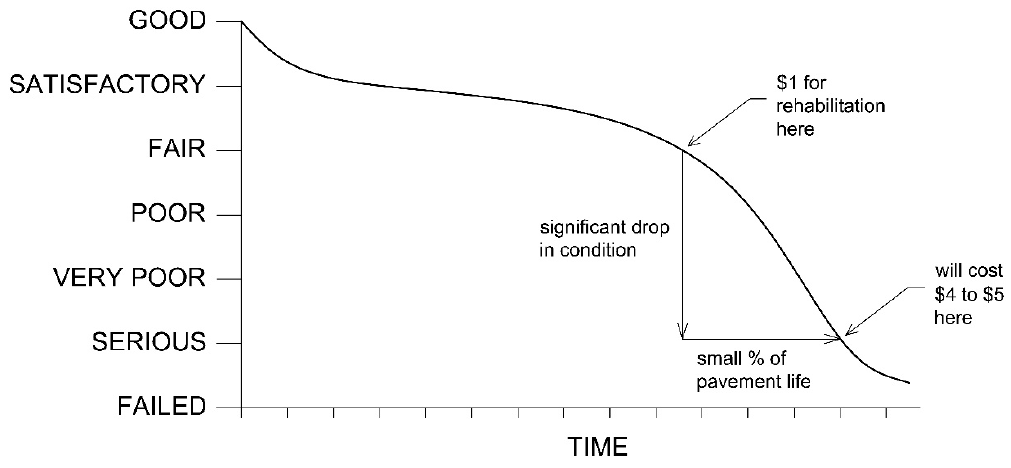
Figure 4. Schematic pavement life cycle. Source: [8].